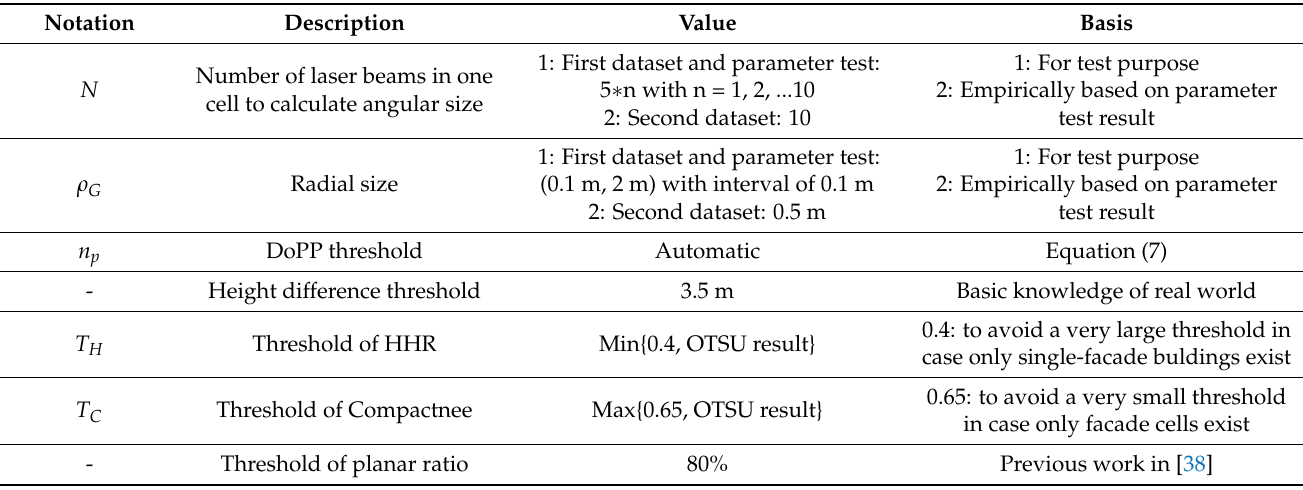
Table 1. Main threshold and parameter